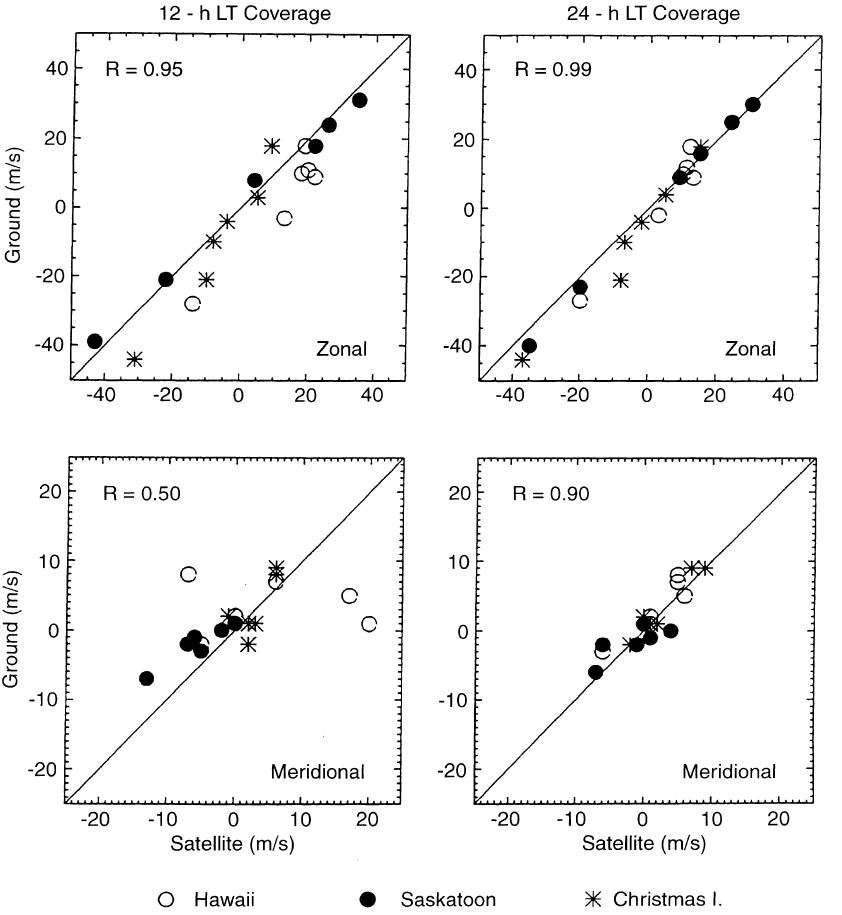
Fig. 2. Comparison between true ( ground- based ) mean winds and those derived by sampling 1 year of hourly radar measurements (Hawaii, Saskatoon, Christmas Island) near 90- km altitude as though from a satellite at 70 (cid:14) inclination precessing in local time. The radar observations are assumed to be independent of longitude in these calculations. Determinations for even months only are shown. Left : 12-h local-time coverage; right : 24-h local-time coverage; Top : zonal component; bottom : meridional component. The R values represent linear correlation coe(cid:129)cients and the 45 (cid:14) diagonals represent the lines of exact agreement between the ground- and space-based